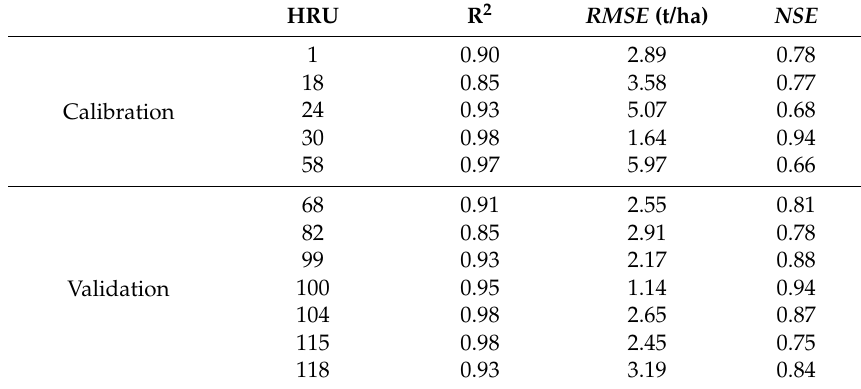
Table 9. Statistical parameters related to shoot dry matter in the calibration and validation phases.